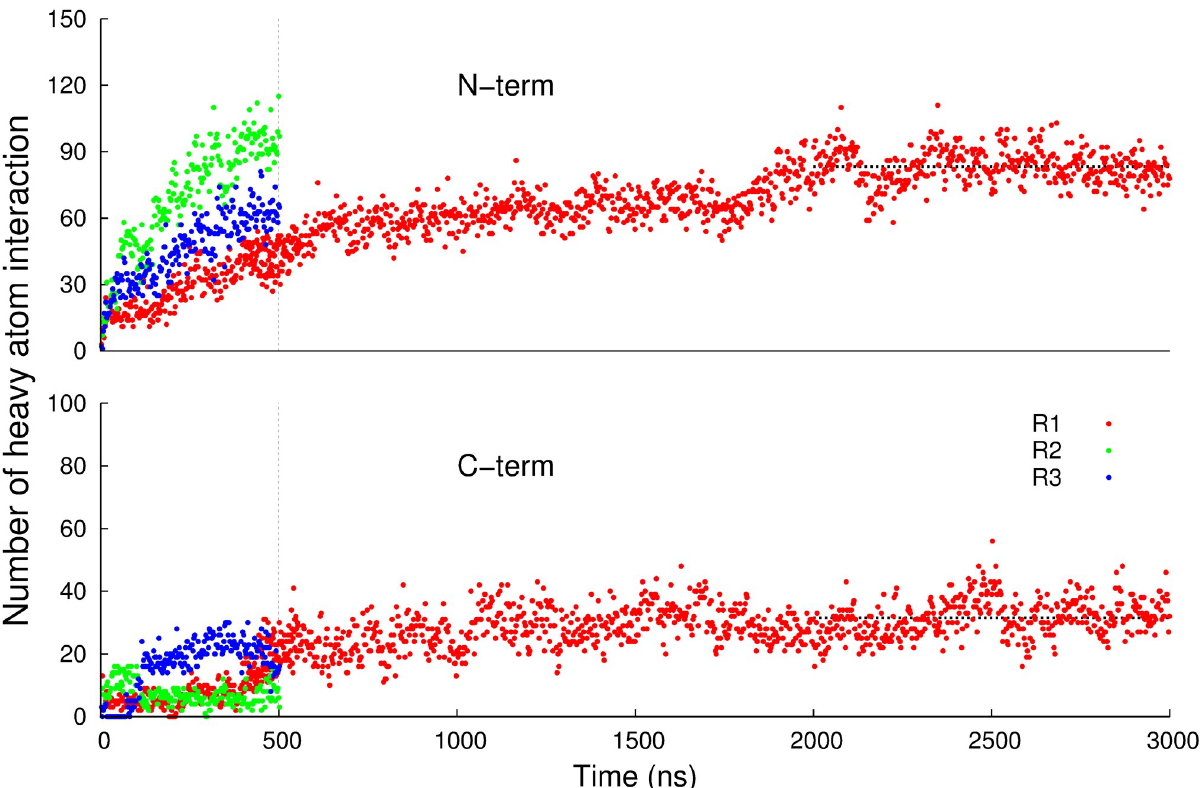
Fig 6. Time profiles of the numbers of contacts between PIP 2 and PLD2 residues within 3.5 Å . Data were obtained from the three replicas of the 10% system (red, green, and blue for R1, R2, and R3 in S5 Fig in S1 File, respectively). R1 has been extended to 3 μ s, while R2 and R3 were simulated for 500 ns. It was calculated for the two segments of hPLD2 separately: ‘N-term’ in the first row and ‘C-term’ in the second row. The vertical dotted line indicates the border between N-term and C-term. The horizontal lines are average numbers for 2–3 μ s: 83.3 ± 7.9 (standard deviation) for N-term and 31.5 ± 5.9 for